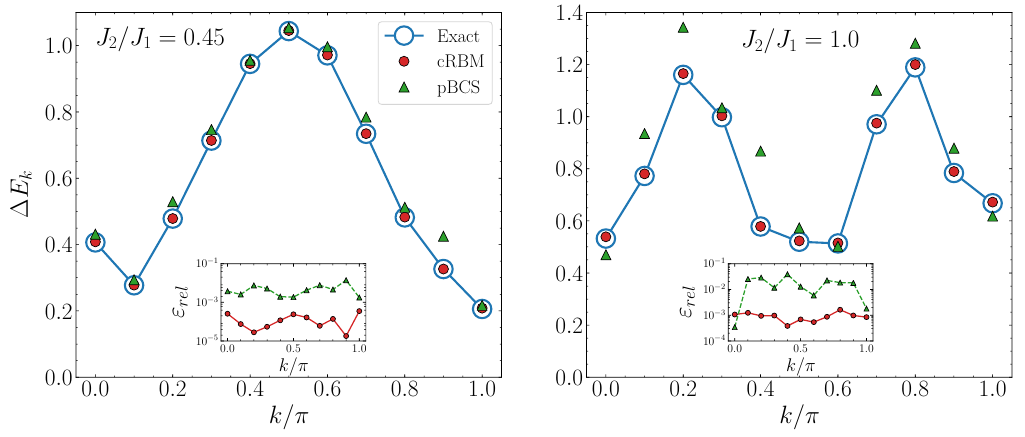
− J Figure 11: Lowest-energy triplet excitation of the J Heisenberg model for 1 2 / J = 0.45 (left panel) and J / J = 1 (right panel), for a chain of N = 20 sites. J 2 1 2 1 ∆ E is the difference between the lowest triplet energy at momentum k and the k = 1 (full ground state energy. Results obtained by the best cRBM Ansatz with α c circles) and the pBCS state (full triangles) are shown, together with exact values (empty circles). The insets show the relative error of the variational results, i.e., (cid:1) / (cid:34) = | (cid:0) E − E | , where E E and E are the exact and variational rel ex,k var,k ex,k ex,k var,k energies of the excited states, respectively.